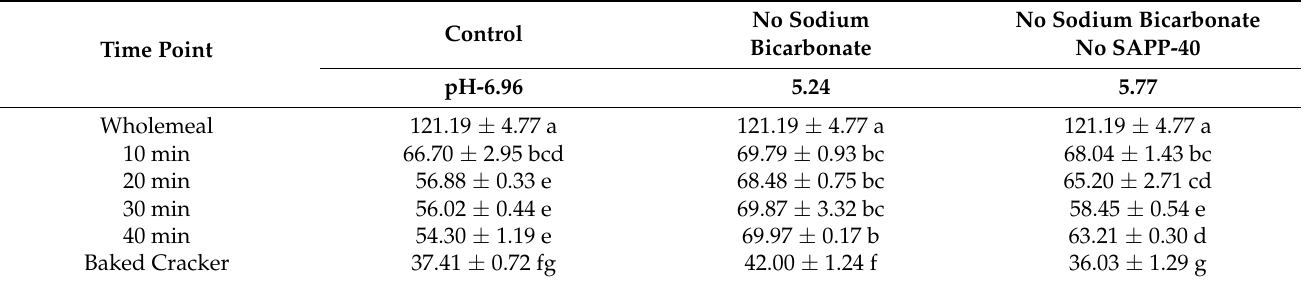
Table 8. Total anthocyanin content (mg anthocyanin/kg wholemeal) of cracker dough (at various rest- ing points) and crackers made from AnthoGrain™ wholemeal (control), without sodium bicarbonate, and without sodium bicarbonate and SAPP-40.